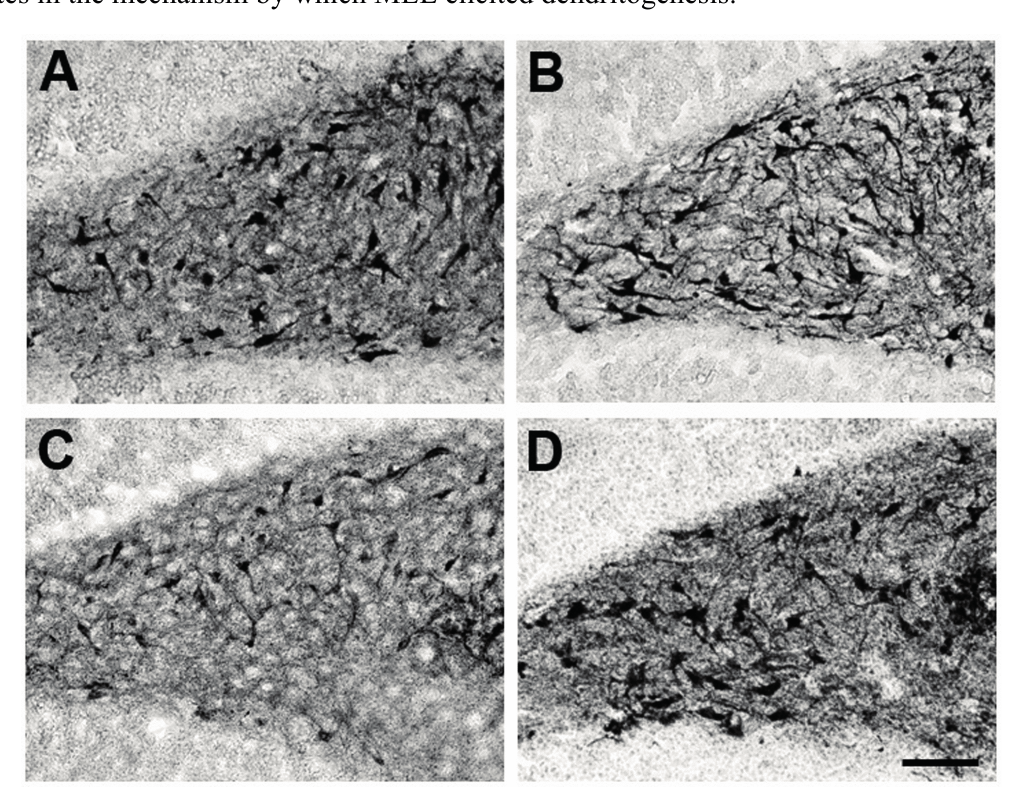
Figure 1. Effect of Ca 2+ /CaM-Kinase II on dendrite formation elicited by